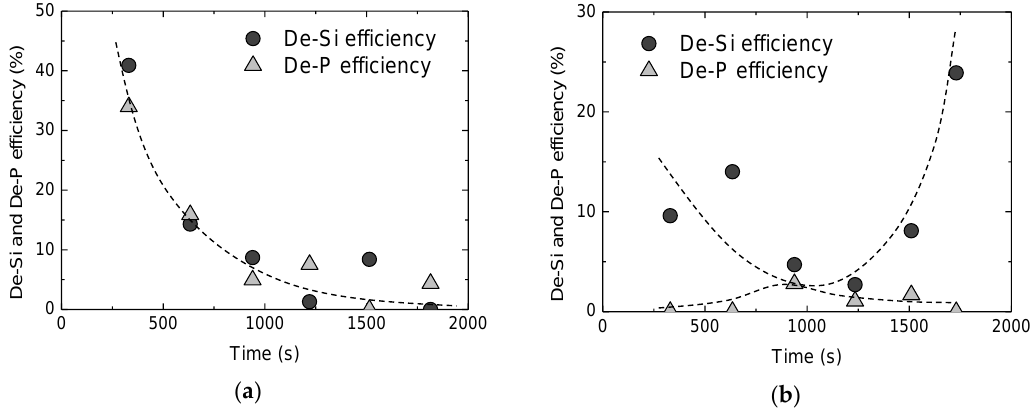
Figure 7. Changes in desiliconisation and dephosphorisation efficiencies with different oxygen supply methods: ( a ) iron ore top charging; ( b ) dehydrated air injection.